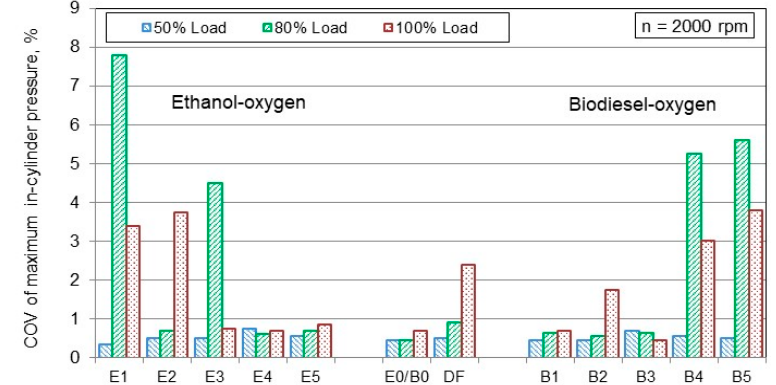
Figure 9. Coefficient of the cyclic variation (COV) of maximum in-cylinder pressure over the 100 consecutive engine cycles as a function of ethanol–oxygen or biodiesel-oxygen mass content in fuel blends for medium (50%), intermediate (80%), and full (100%) loads corresponding to the respective